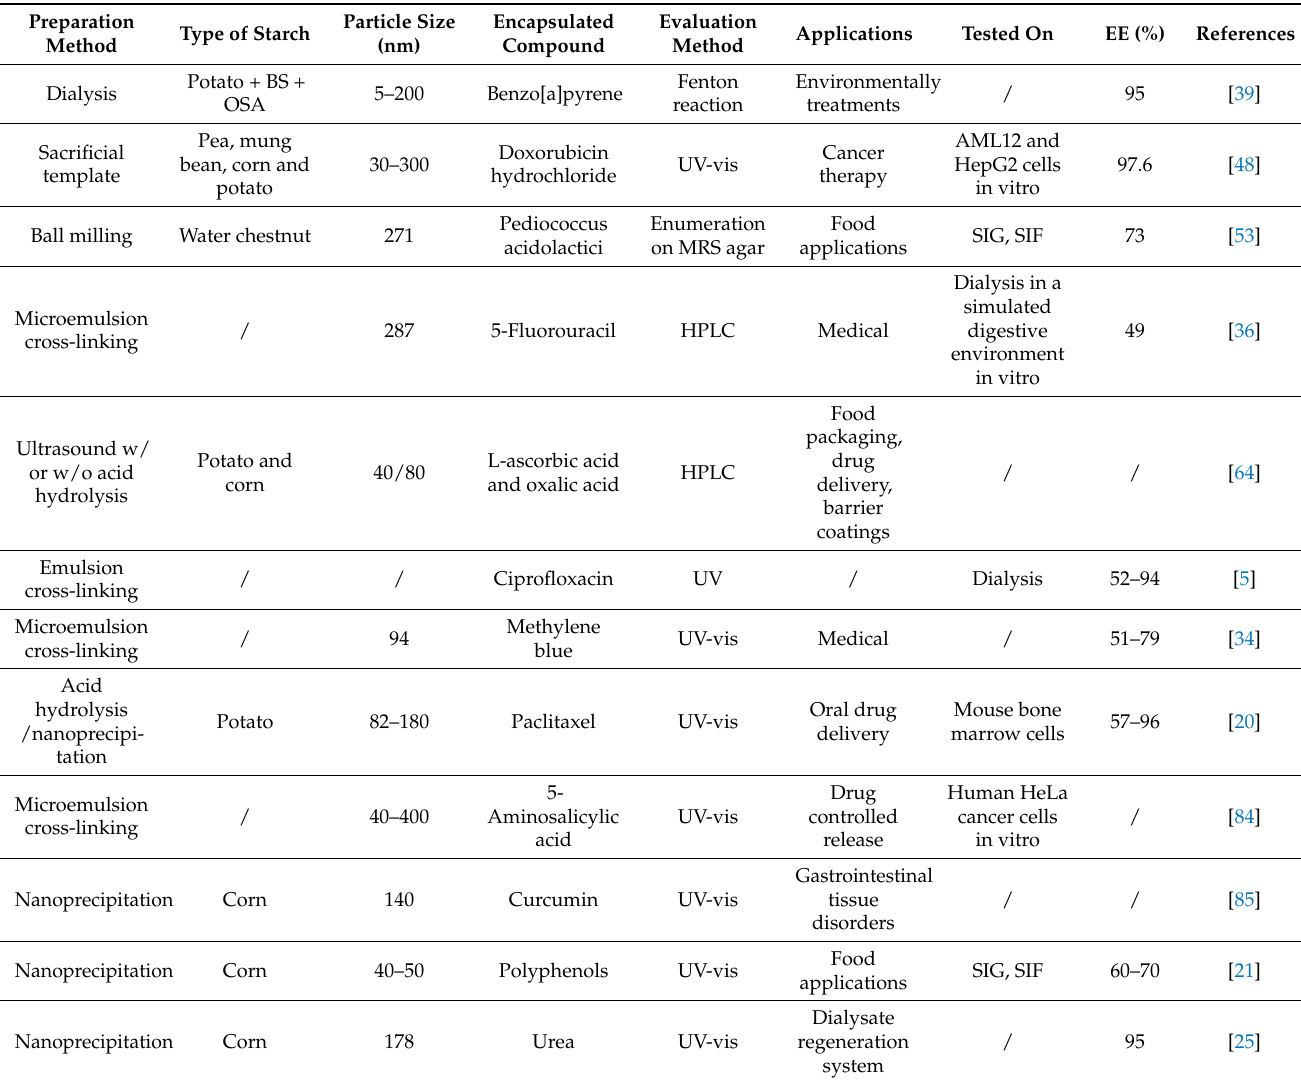
Table 3. Examples of recent studies of SNPs synthesis methods and encapsulation of different compounds through indirect